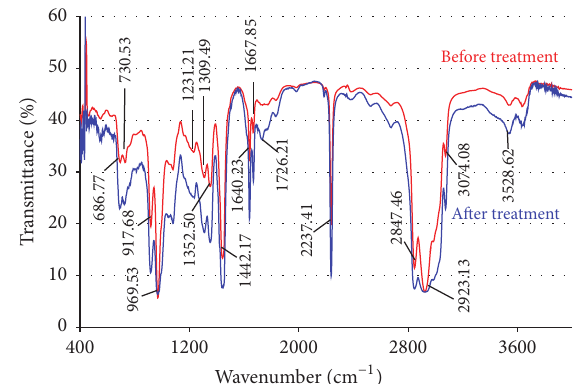
Figure 7: FTIR spectra of NR crepes before and after UV/ozone treatment.